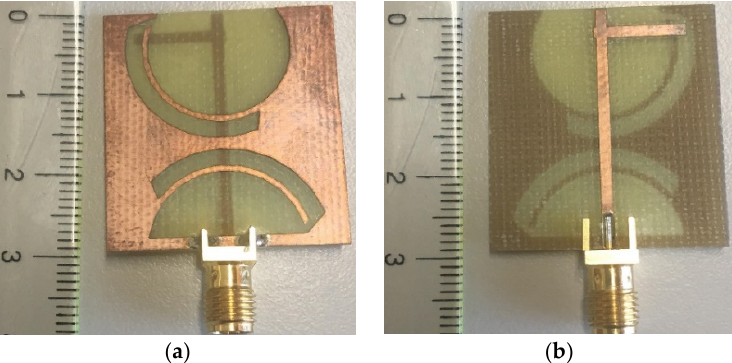
Figure 12. Photograph of the realized prototype: ( a ) top view and ( b ) bottom view.